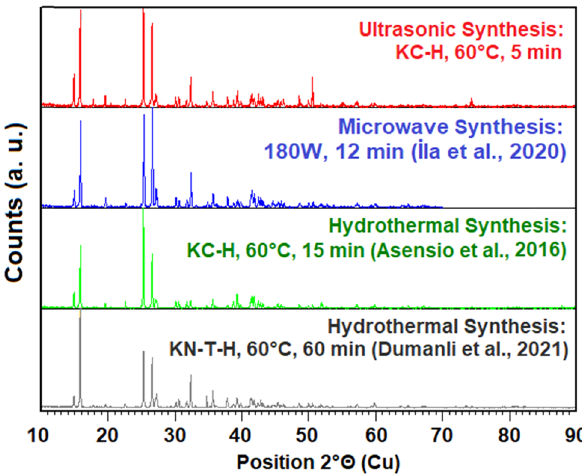
Figure 4: XRD pattern of the highest XRD scored santite, and com - parison with the literature.